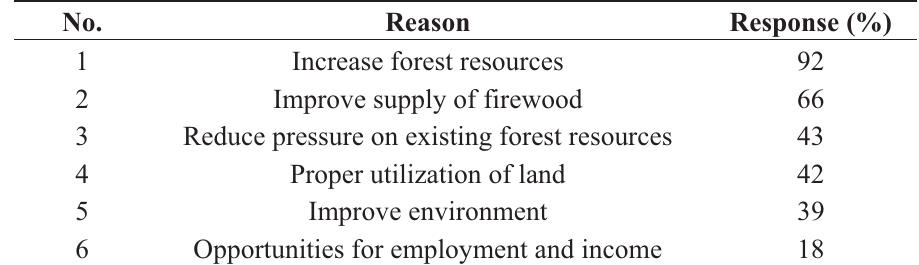
Table 5. Respondents’ answers on possible benefits derived from energy wood plantation on wastelands ( N =